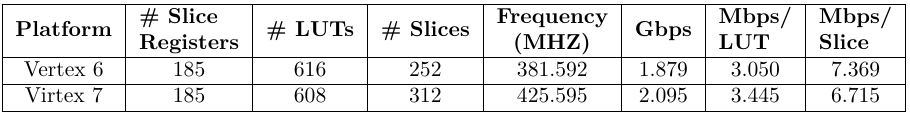
Table 3: Beetle[Light+] Implemented FPGA Results